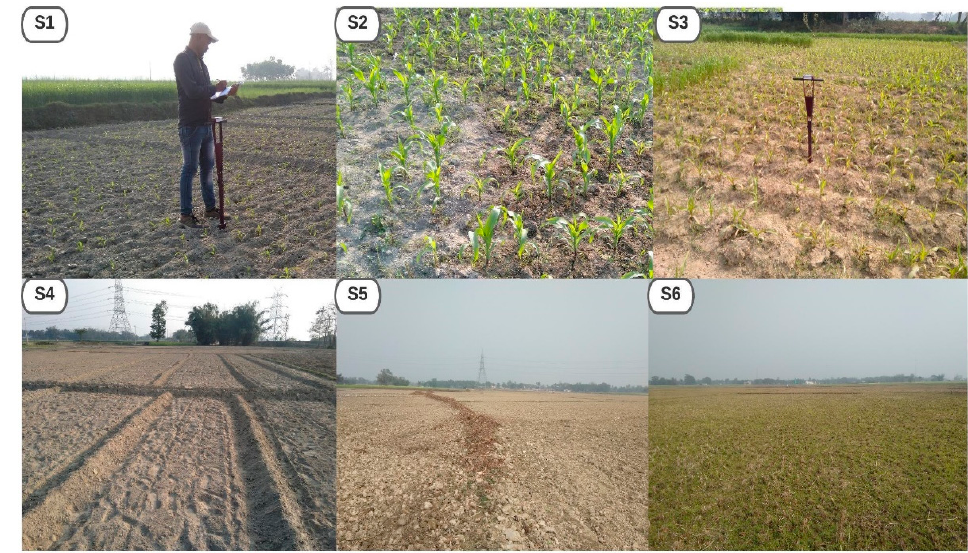
Figure 2. Measurement of in-situ SSM using TDR-300 at sample plots in KRB and the corresponding coordinates of S1 to S6 were provided in Table A1. The sample plots S1–S3 represent maize fields, whereas S4–S6 represent bare soil.